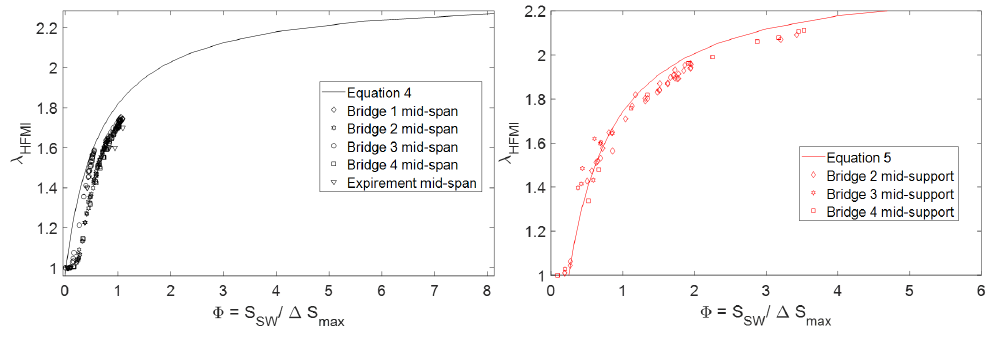
Figure 19. Exact λ HFMI and Φ for the case study bridges and experiments compared with the proposed curves for the mid-span section ( Left ); and mid-support section ( Right